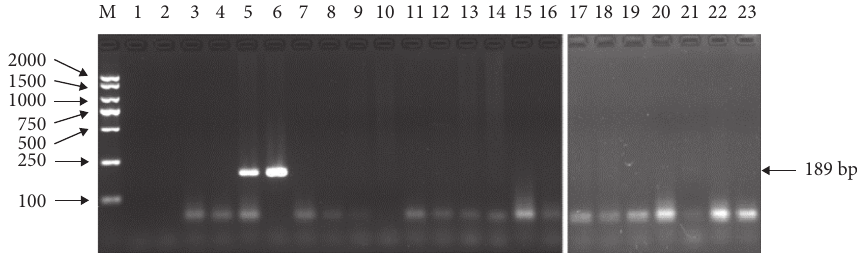
Figure 3: Specificity of the spt5 gene detected by qualitative PCR. M DNA marker DL 2000; lanes 1-2, Boletus magnificus W.F.Chiu; 3-4, Lentinus edodes ; 5-6, Boletus reticulatu s; 7-8, Agrocybe aegiri t; 9-10, Leccinum extremiorientale (L.Vass.) Singer; 11-12, Boletus griseus Frost; 13-14, Boletus sinicus W.F.Chiu; 15-16, Russula virescens ; 17-18, Collybia albuminosa ; 19-20, Lactarius volemus ; 21-22, Pleurotus eryngii ; 23, negative control.